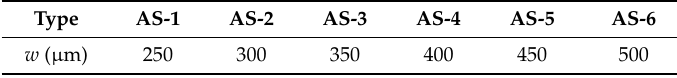
Table 1. The parameters of the six chips with di ff erent w values.